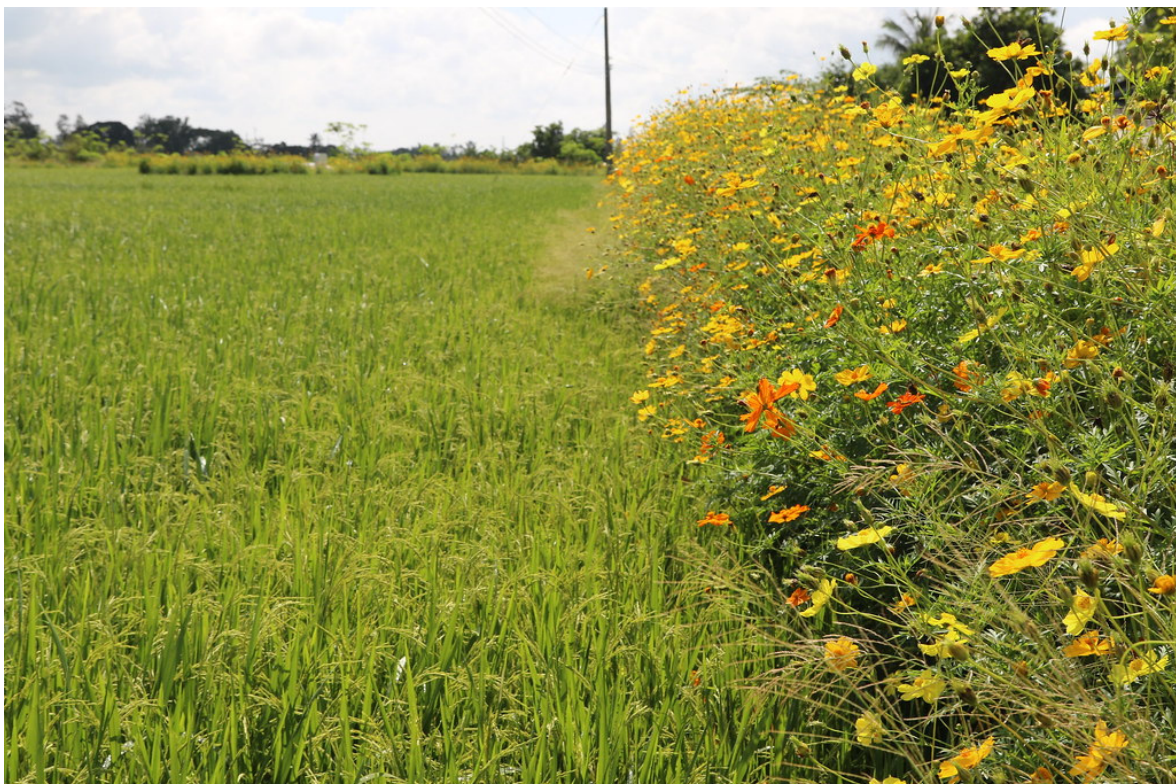
Figure 1. A rice bund planted with flowers as part of the ecological engineering approach to pest management in southern Vietnam. Image ‘Ecological engineering’ by CGIAR Climate licensed under CC BY-NC-SA 2.0.